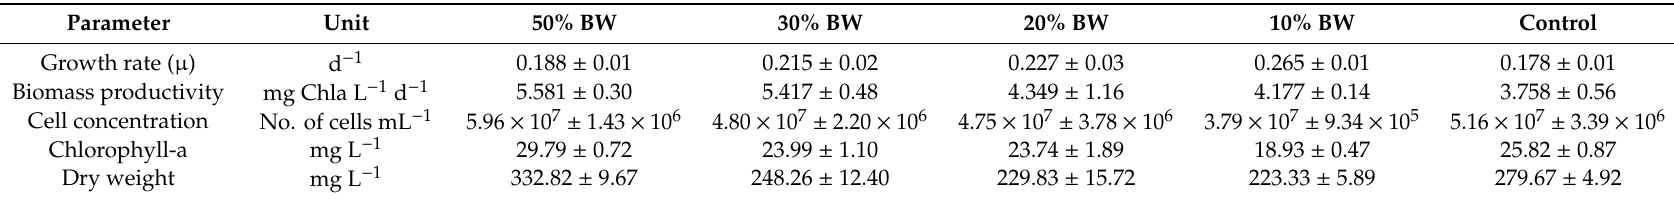
Table 3. Average growth rates, maximum biomass productivity during exponential phase and total biomass of Chlorella vulgaris with standard deviations in di ff